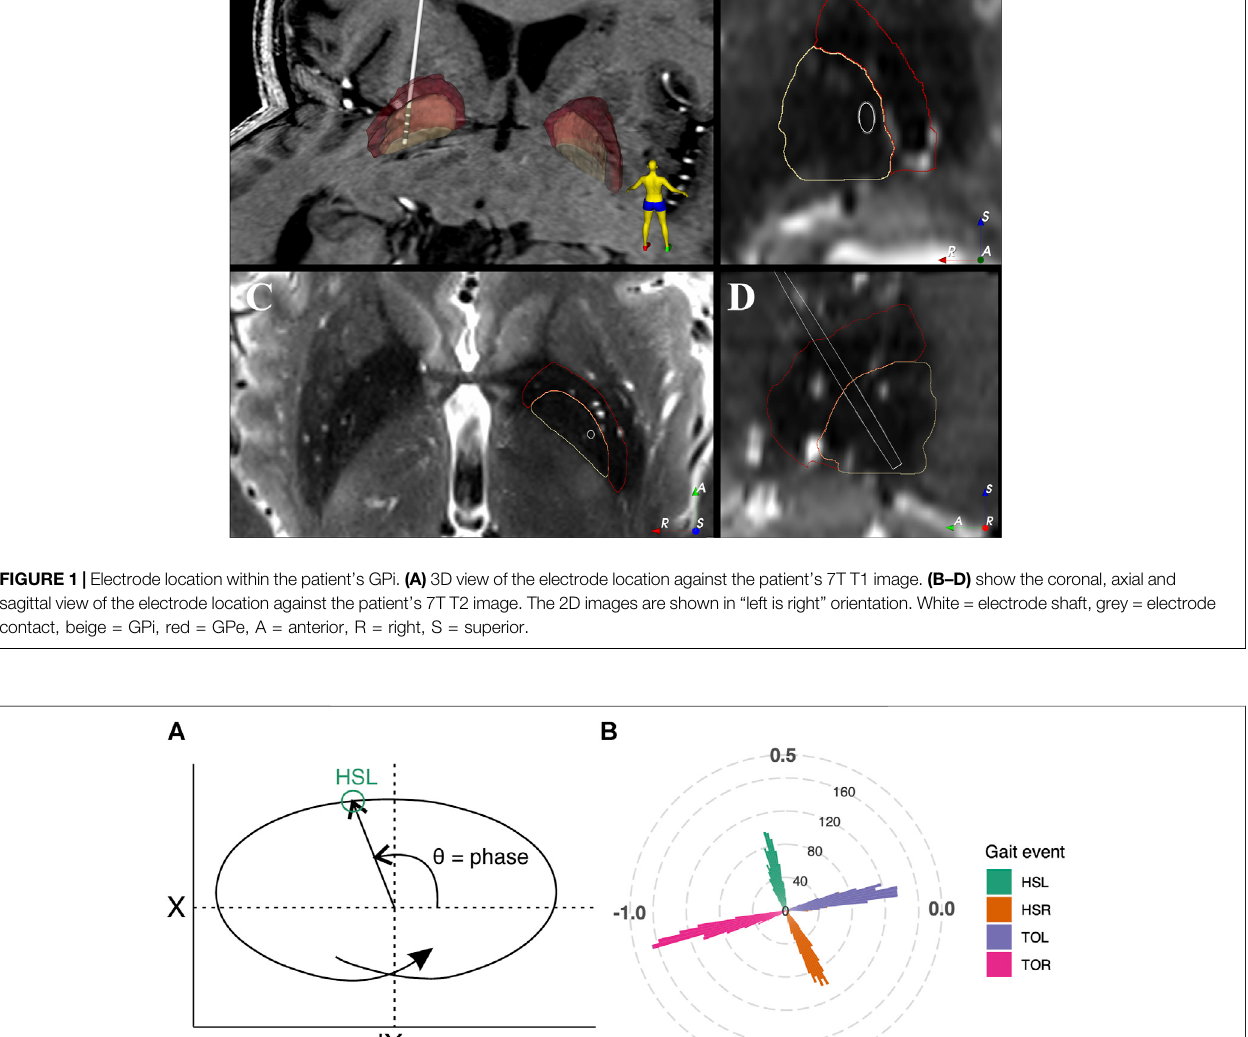
The treadmill movement and COP trajectory were down- sampled and interpolated (scipy.signal.decimate, numpy.interp) (Virtanen et al., 2020; Harris et al., 2020) to match the LFP sampling frequency. COP X coordinate (mediolateral axis) was represented in the phase plane (X vs. dX/dt), in polar coordinates (r, theta) with origin set at the average for the whole trial ( Figure 2A , Supplementary Figure S2 ). The theta value was extracted as the gait